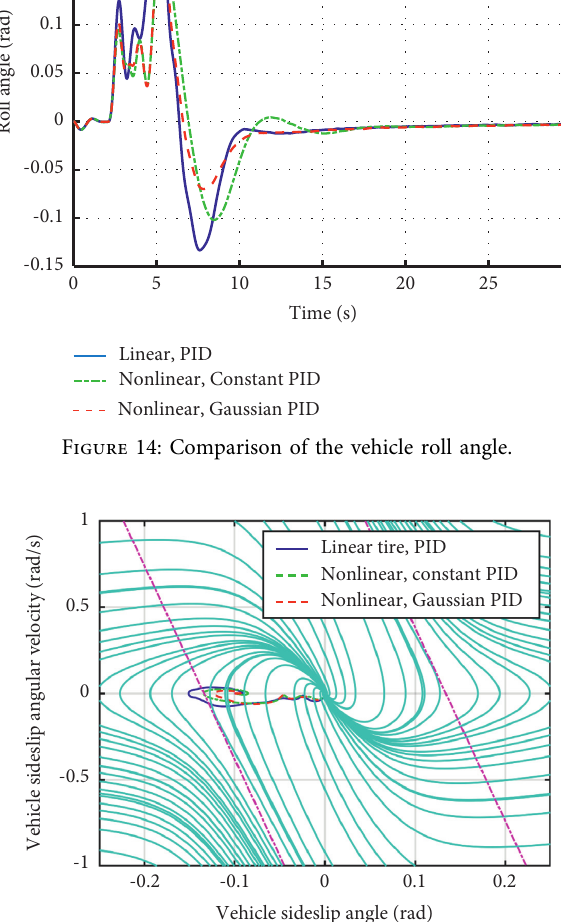
Figure 15: Comparison of sideslip angle and side slip angular velocity phase